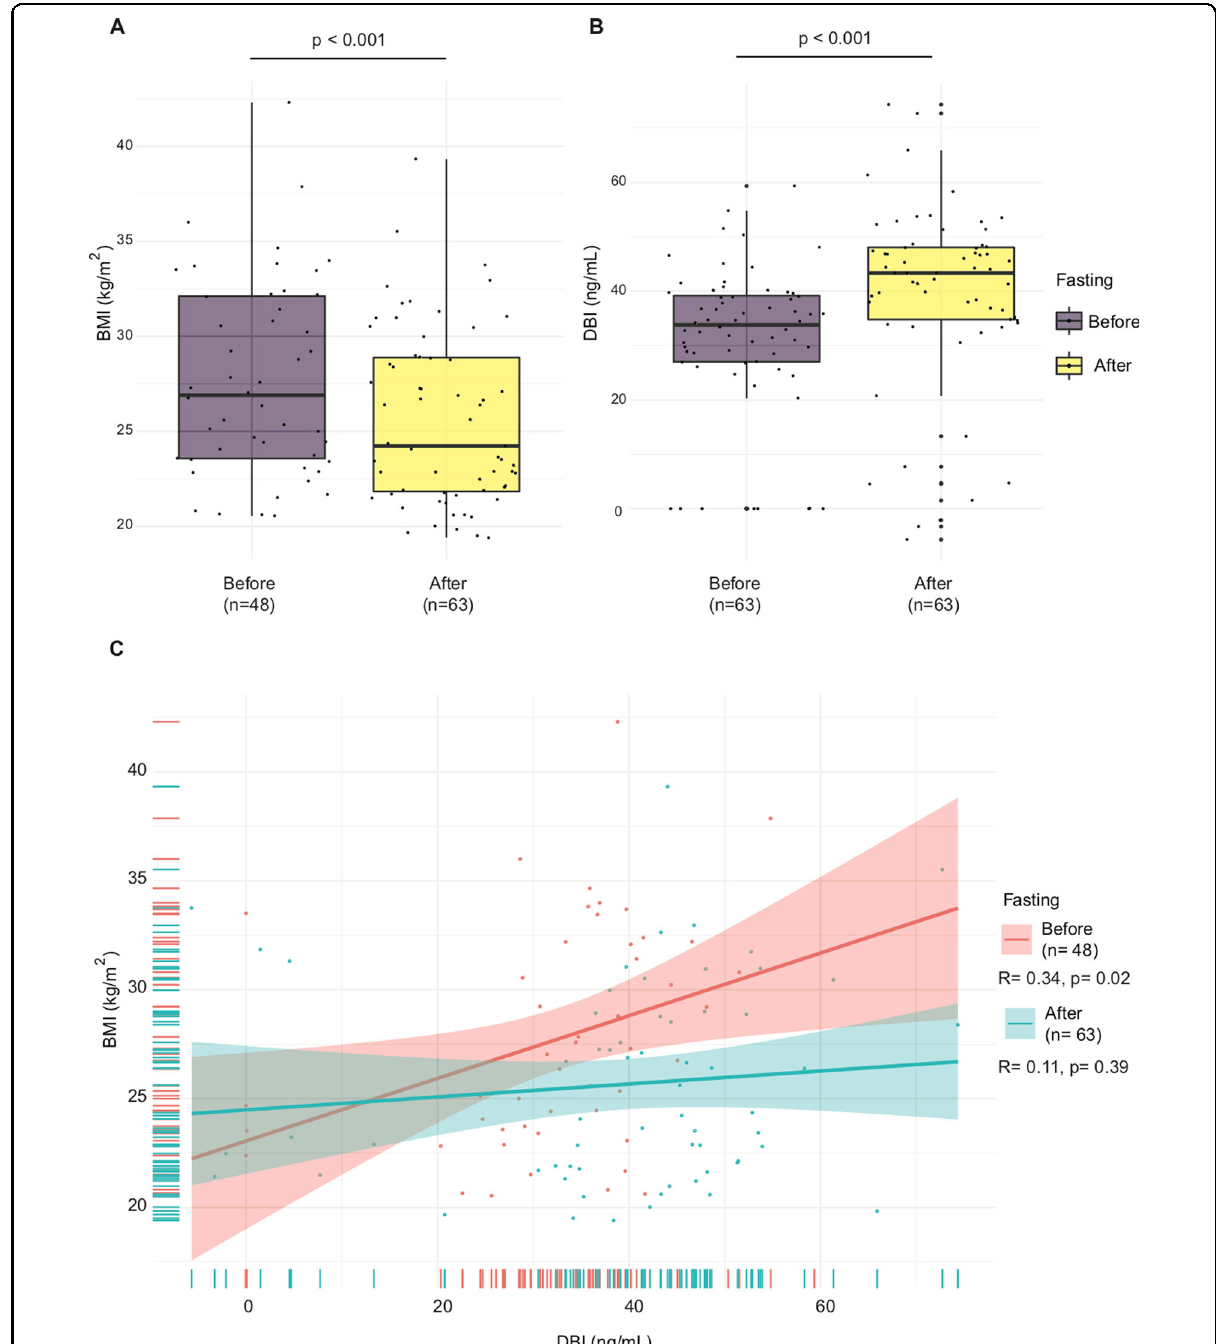
Fig. 4 Effects of fasting on ACBP/DBI levels. Fasting induces a decrease in BMI ( A ), an increase of ACBP/DBI ( B ) and a loss of the correlation between ACBP/DBI and BMI ( C ). Box and whisker plots representing BMI (kg/m 2 ) ( A ) and ACBP/DBI levels (ng/mL) ( B ) before and after fasting in the BWC cohort. Scatter plots with regression lines between ACBP/DBI (ng/mL) and body mass index (kg/m 2 ) ( C ) before and after fasting in the BWC cohort. Pearson ’ s correlation coef fi cient (R) and their p value and number of samples available ( n ) are shown in the legend of each panel. Note that the results of paired t tests limited to patients with complete BMI data (before and after fasting, n = 48) show a similar difference in terms of BMI decrease ( p < 0.001) and DBI increase ( p <